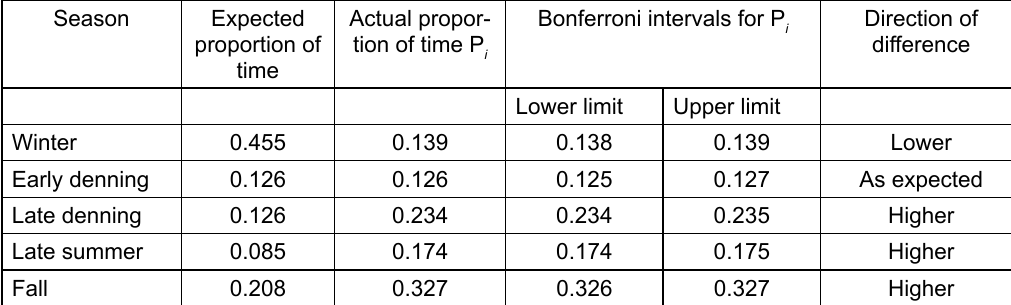
Table 1. Simultaneous confidence intervals for wolf seasonal use of the Nushagak Peninsula, Togiak National Wild- life Refuge, southwestern Alaska, 2007 – 2012. Time spent on the Nushagak Peninsula was significantly (P < 0.01) higher than expected in Late Denning, Late Summer, and Fall, lower than expected in Winter, and proportional in the Early Denning